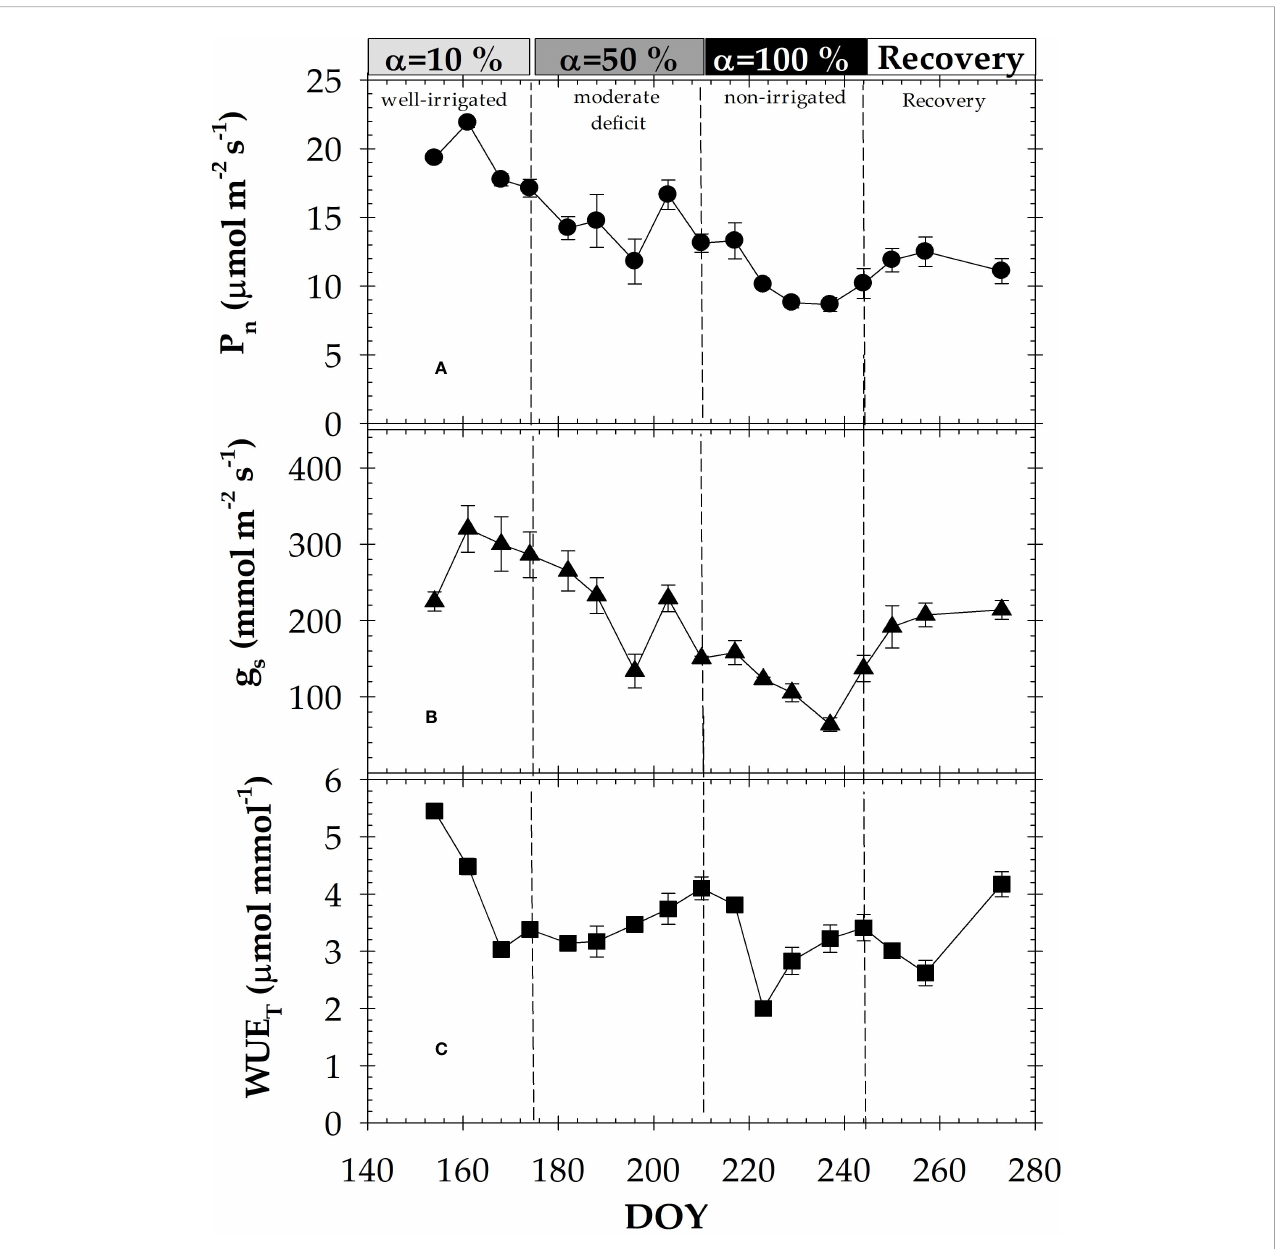
FIGURE 5 Seasonal time-course of: (A) net photosynthesis (P n ); (B) stomatal conductance (g s ); and (C) transpiration ef fi ciency (WUE T ) during the experimental period. Each point is the mean of four leaves. Vertical bars in data points are ± SE (not shown when smaller than the symbols). Dashed vertical lines delimit each irrigation criterion. DOY: Day of the